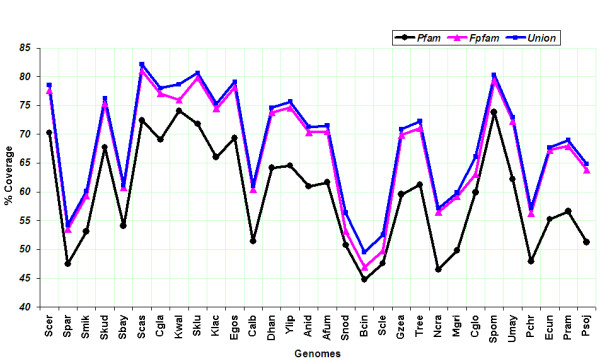
Comparison of FPfam and Pfam results for sequences from the original 30 fungal genomes. For each of the 30 original genomes, the Figure shows the percentage of sequences found to contain at least one domain using Pfam, FPfam and a combination. The average coverage was found to be 56.55% (Pfam), 64.29% (Fpfam) and 65.60% (combination). These matches were found against 2953 domains represented in the FPfam library. Please note that genome names are shown as a four letter code; comprising of the first letter from the genus name and 3 letters from the species name, also shown in the Table 1.